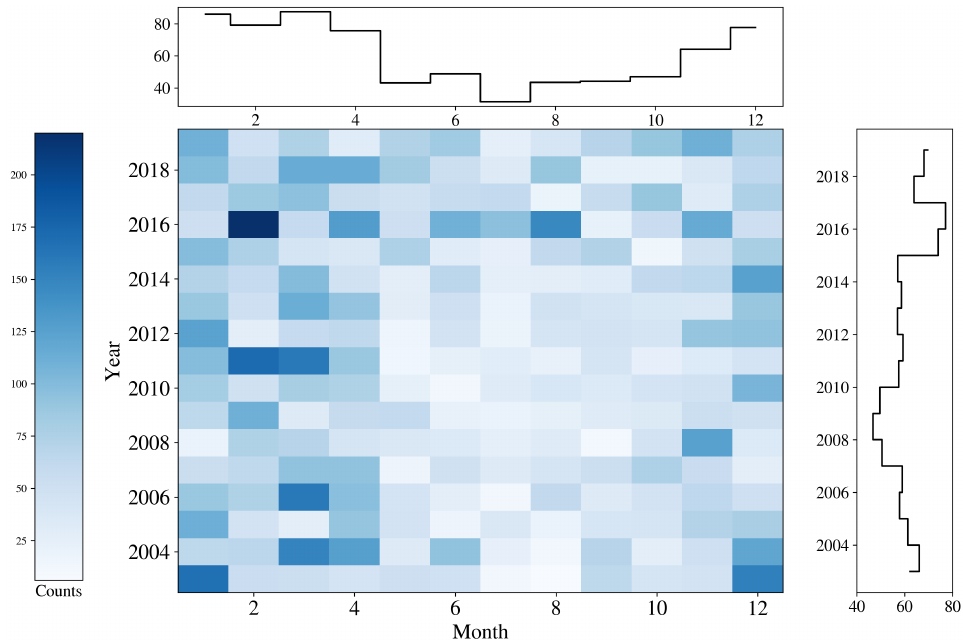
Figure 5. Incidence (counts) of outlier cutouts broken down by month and year. The primary feature is seasonal, i.e., a higher number of outlier cutouts during boreal winter months than summer. There was also a weak but plausible increase in the incidence of outliers over the past ∼ 10 years.